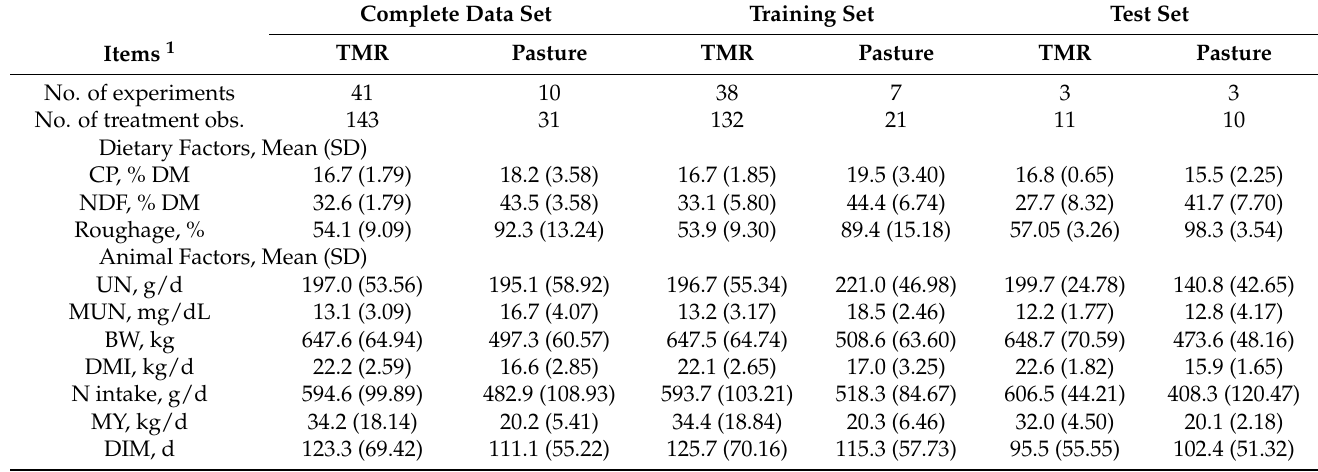
Table 1. Description of the data set generated from the literature used for model development (training set) and testing models (test set) where cows were fed either a total mixed ration (TMR) or fresh